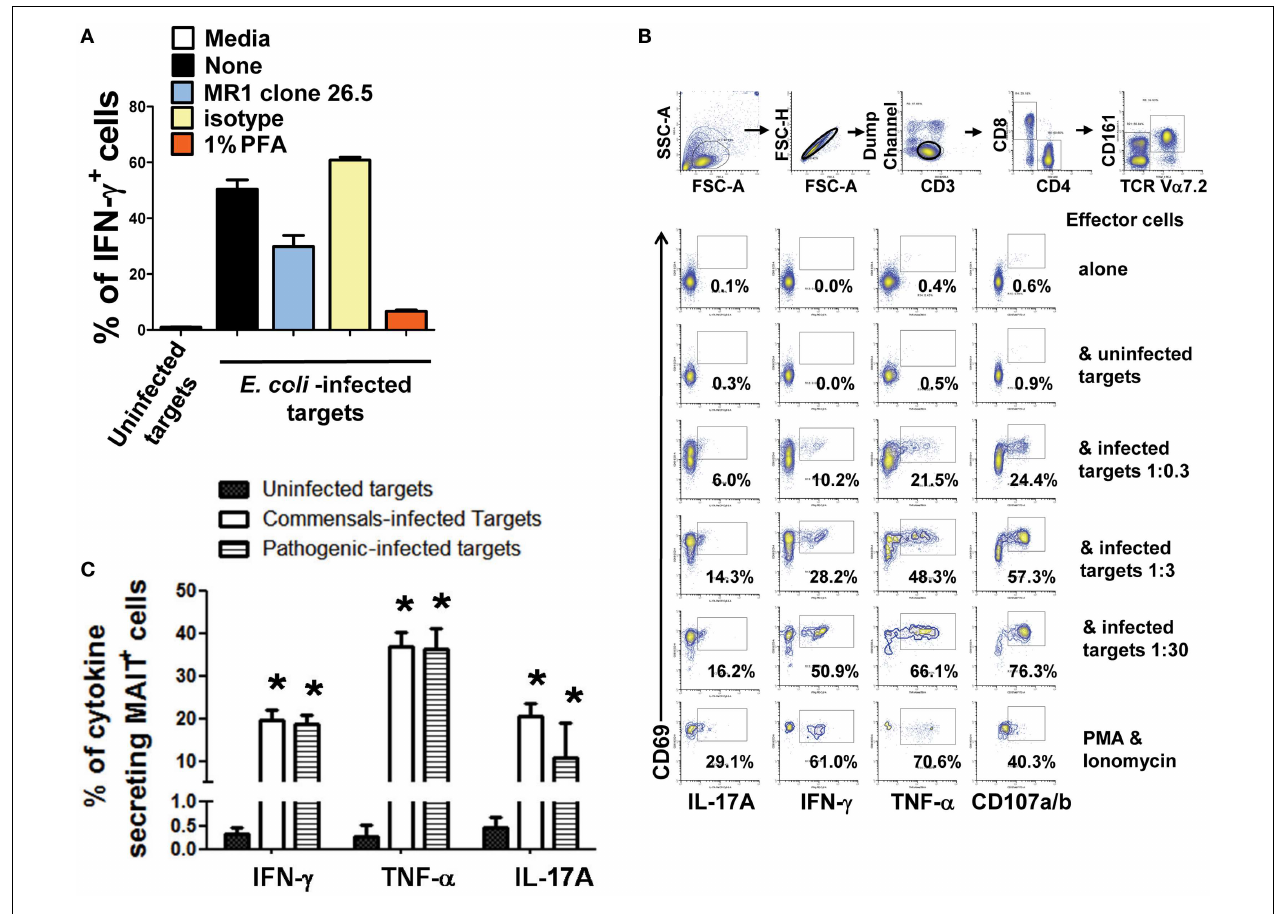
(CD45 + ) from analysis.This was followed by additional gating on CD3, CD8, TCR α 7.2, and CD161 to identify CD107a/b + and cytokine-producing (IFN- γ , TNF- α , and IL-17A) MAIT cells. (C) Percentage of MAIT cells secreting either IFN- γ ,TNF- α , or IL-17A cytokines when exposed to commensal (i.e., E. coli BL21, HS, or Nissle 1917 strains) or enteric pathogenic [ S. typhi , Enteropathogenic E. coli (EPEC), or Entero-Invasive E. coli (EIEC)] bacteria-infected B-LCL cells were also evaluated. Bars represent mean ± SE. p Values of < 0.05 were considered statistically significant. *Uninfected vs. either commensal or pathogenic-infected targets. Comparisons between groups were performed using Kruskal–Wallis OneWay Analysis ofVariance on Ranks. Data are representative of two (A,B) and five (C)